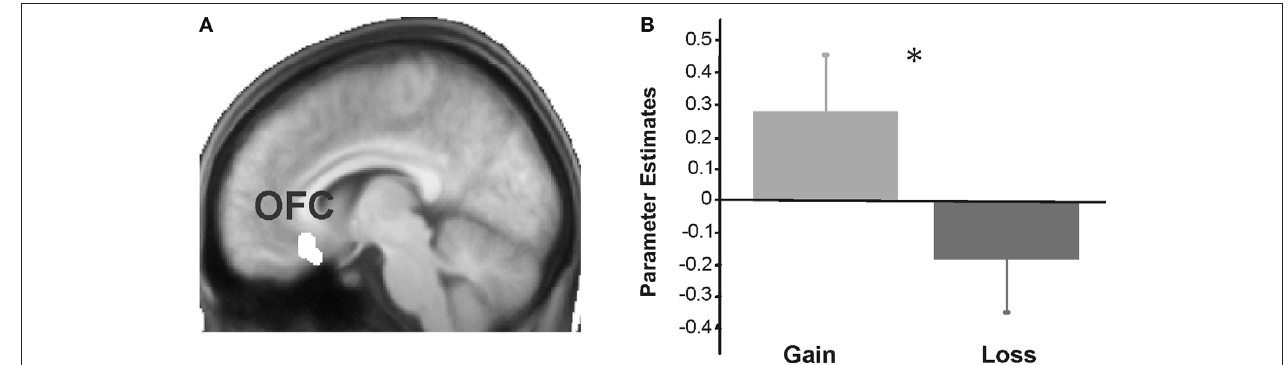
interest selected superimposed in the group-averaged structural MRI image in standard stereotactic space. (B) The right panel shows a bar graph depicting the beta values (general linear model parameter estimates) for gains and losses. Error bars represent standard errors about the mean across